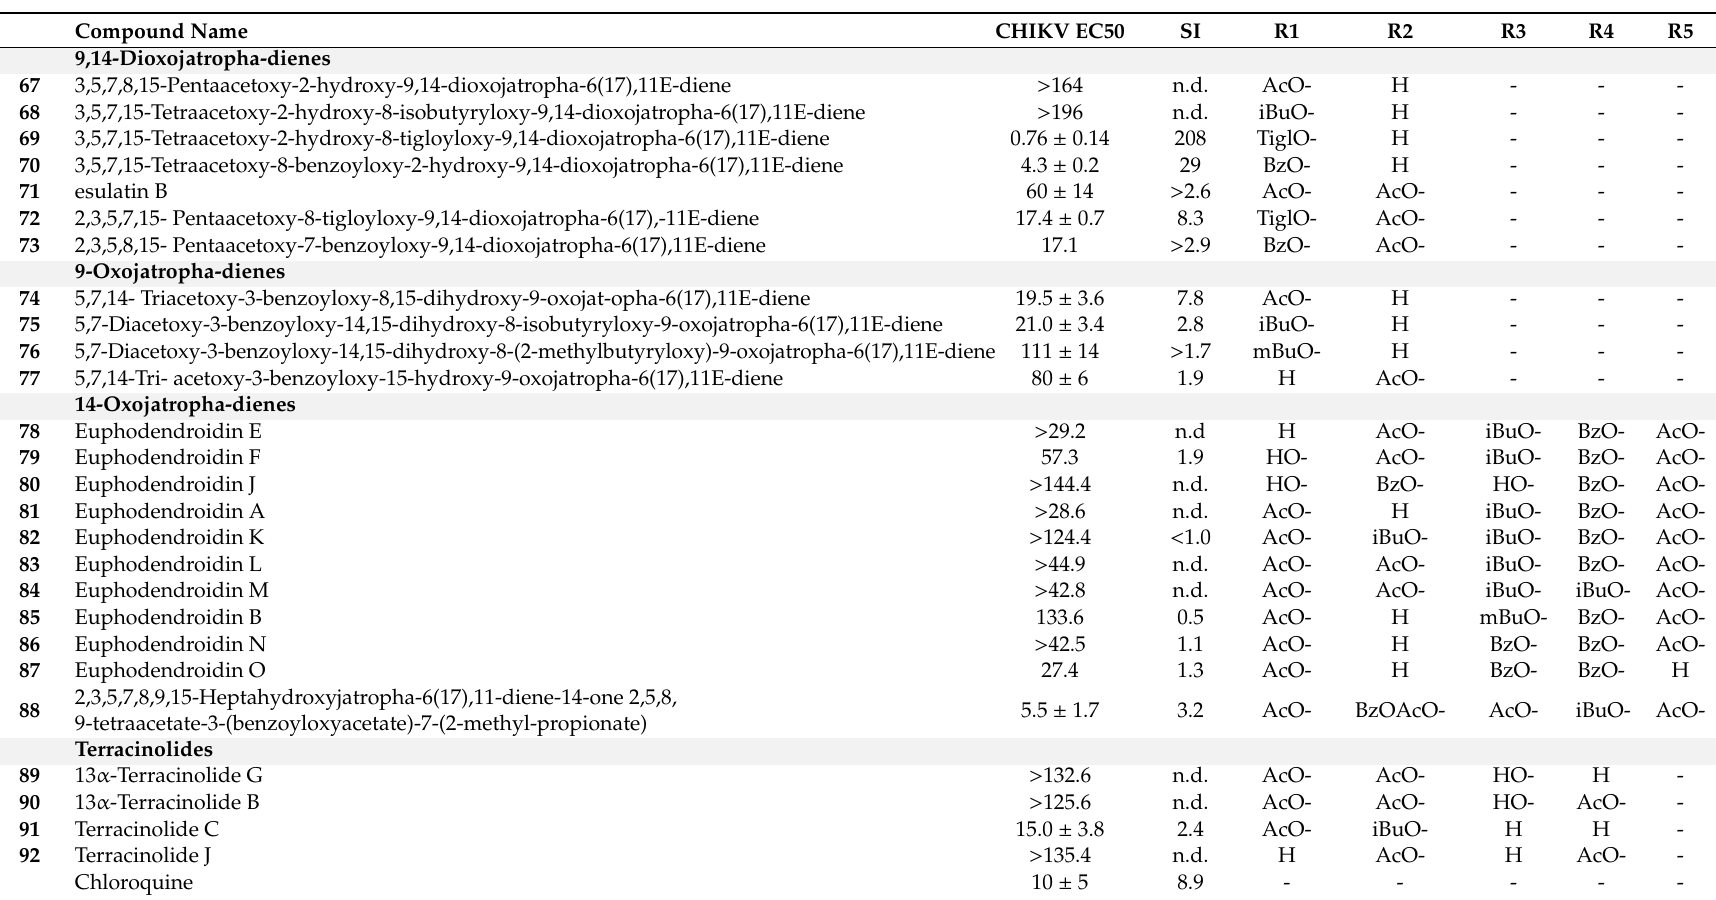
Table 3. Anti-CHIKV activities of jatrophanes 67 – 92